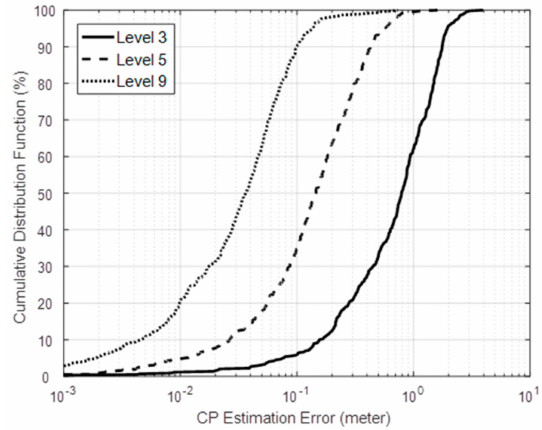
Figure 10. Error statistics under Levels 3, 5 and